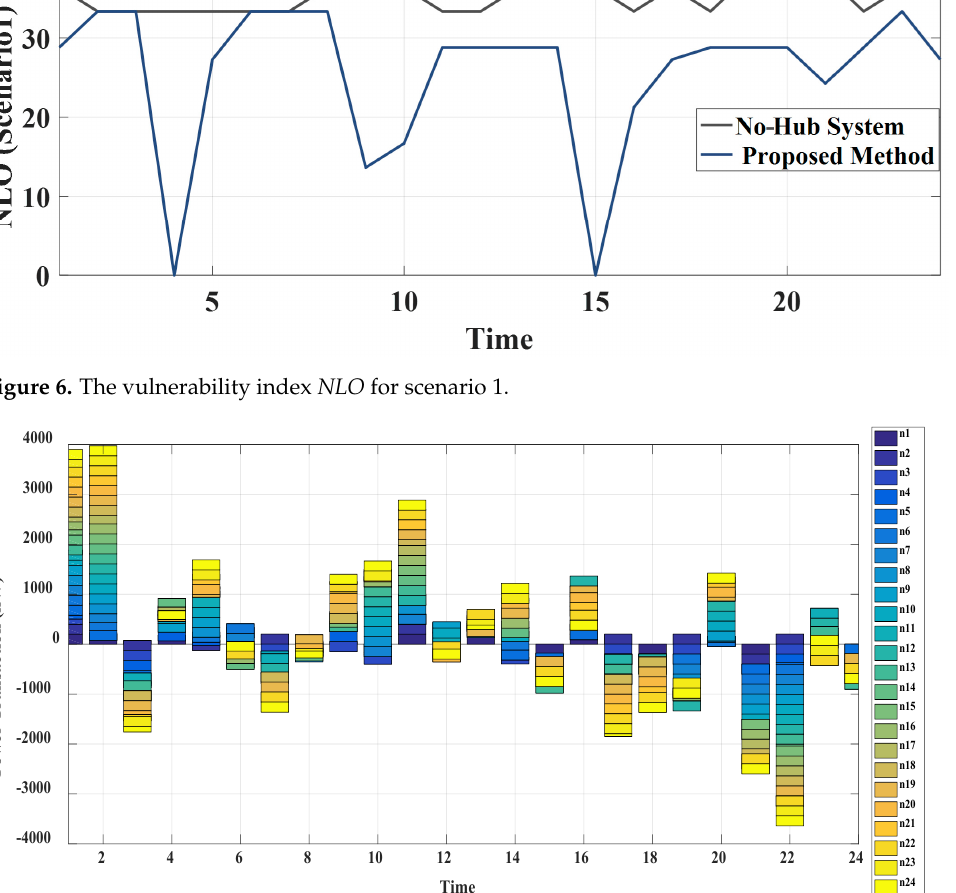
Figure 8. The CHP power for two methods: (1) proposal (2) no hub.